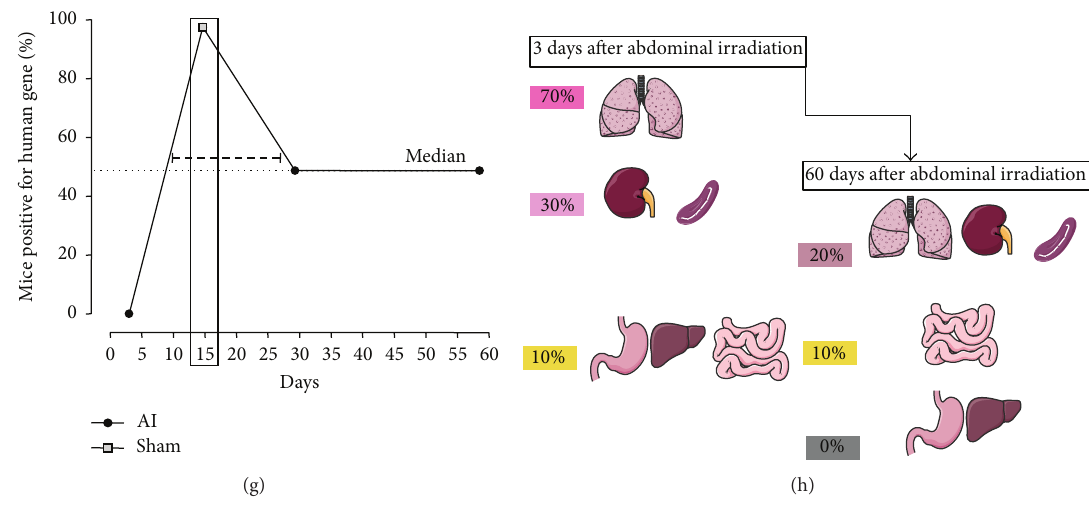
Figure 1: Kinetics of implantation of hMSCs during 60 days after abdominal irradiation. The percentage of positive mice for the human 𝛽 -globin gene detected by PCR (AI) has been calculated after abdominal irradiation (AI). The human gene has been detected in (a) stomach, (b) jejunum, (c) lungs, (d) liver, (e) kidney, (f) spleen, and (g) bone marrow. The tissues were collected at 3, 15, 30, and 60 days after acute AI. The percentages represent the ratio (number of positive mice for the human beta-globin presence divided by total number of animals tested). At each analysis time, each group consisted of 10 animals. The control (named sham) consists in nonirradiated mice injected with 5 ⋅ 10 6 hMSCs. The dotted line represents the median of the positive animal percentage during the 60 days after radiation exposure. (h) Illustration of anatomical variations in the presence of MSC after acute abdominal